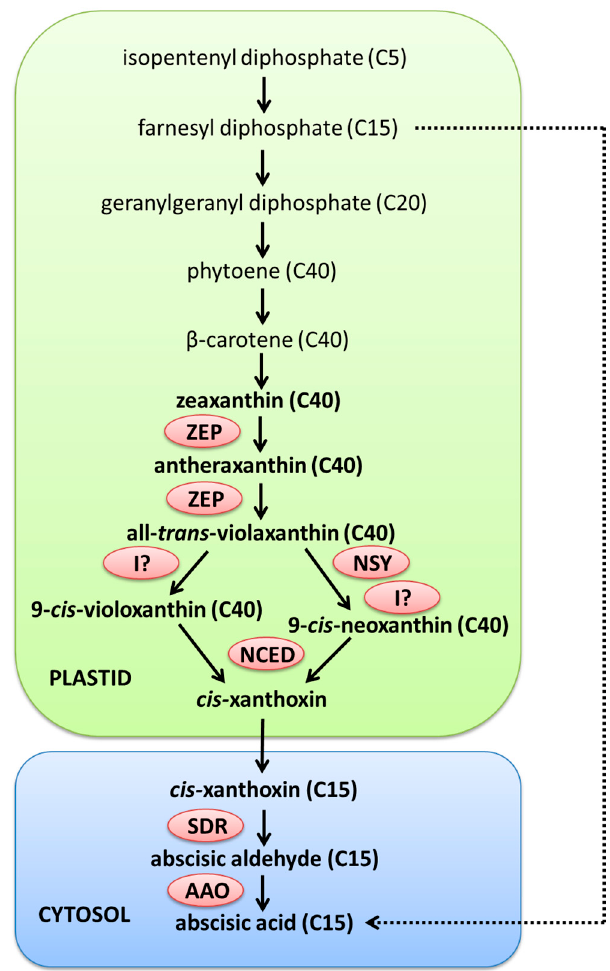
Figure 1. The biosynthesis of abscisic acid (ABA) in higher plants occurs via an indirect pathway (marked with solid, black arrows) and is initiated from the cleavage of β -carotene (C40). Initial steps in ABA biosynthesis occur in plastids, while final reactions take place in cytosol. In a direct pathway (marked with dashed, black arrow), which occurs in some fungi, ABA synthesis starts with the β -carotene precursor farnesyl diphosphate (C15). ZEP, zeaxanthin epoxidase; NSY, neoxanthin synthase; I?, unknown isomerase; NCED, 9-cis-epoxycarotenoid dioxygenase; SDR, short-chain alcohol dehydrogenase/reductase; AAO, abscisic aldehyde oxidase.